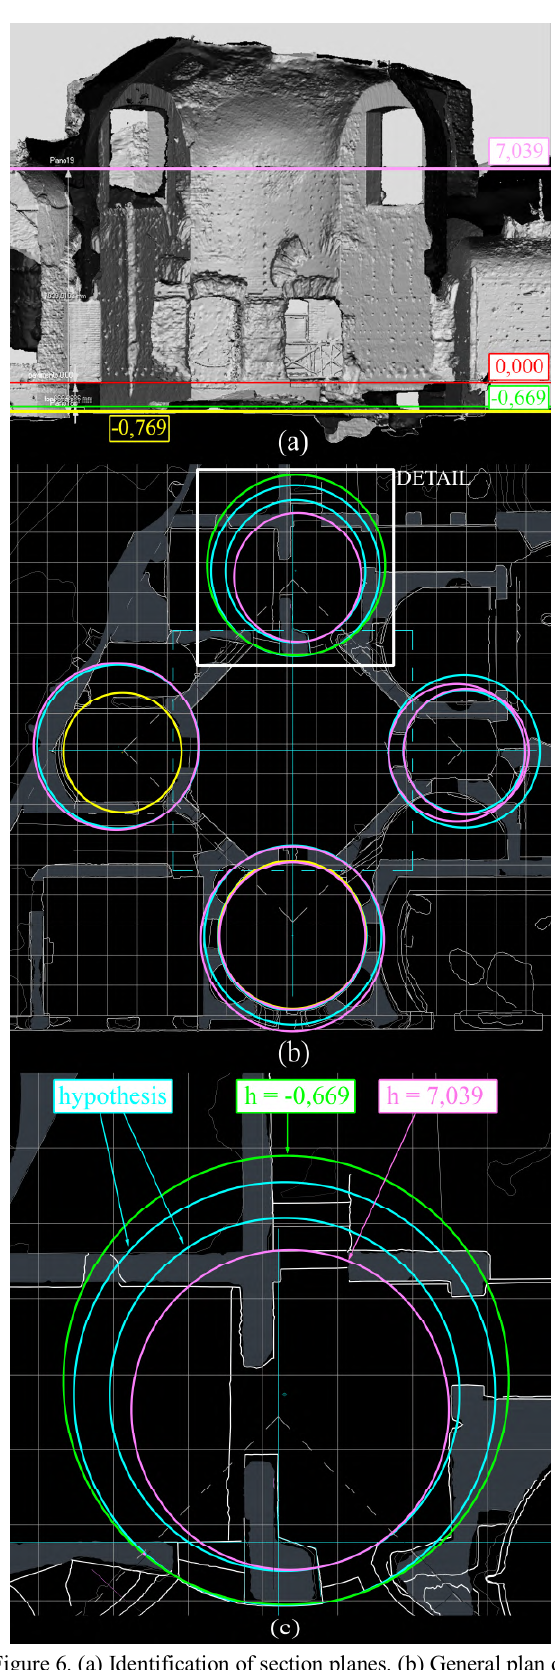
Figure 6. (a) Identification of section planes. (b) General plan of Small Baths with best-fitting circumferences extracted by Geomagic Design X. (c) Best-fitting circumferences and